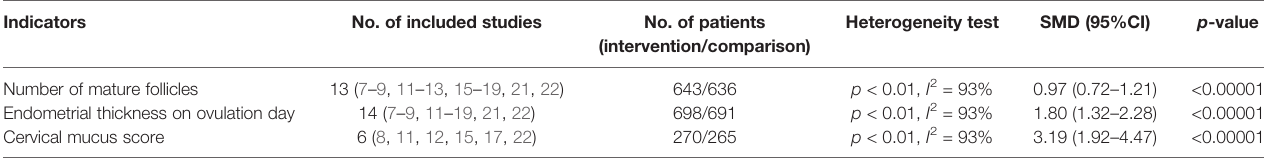
TABLE 2 | Results of indicators related to follicular